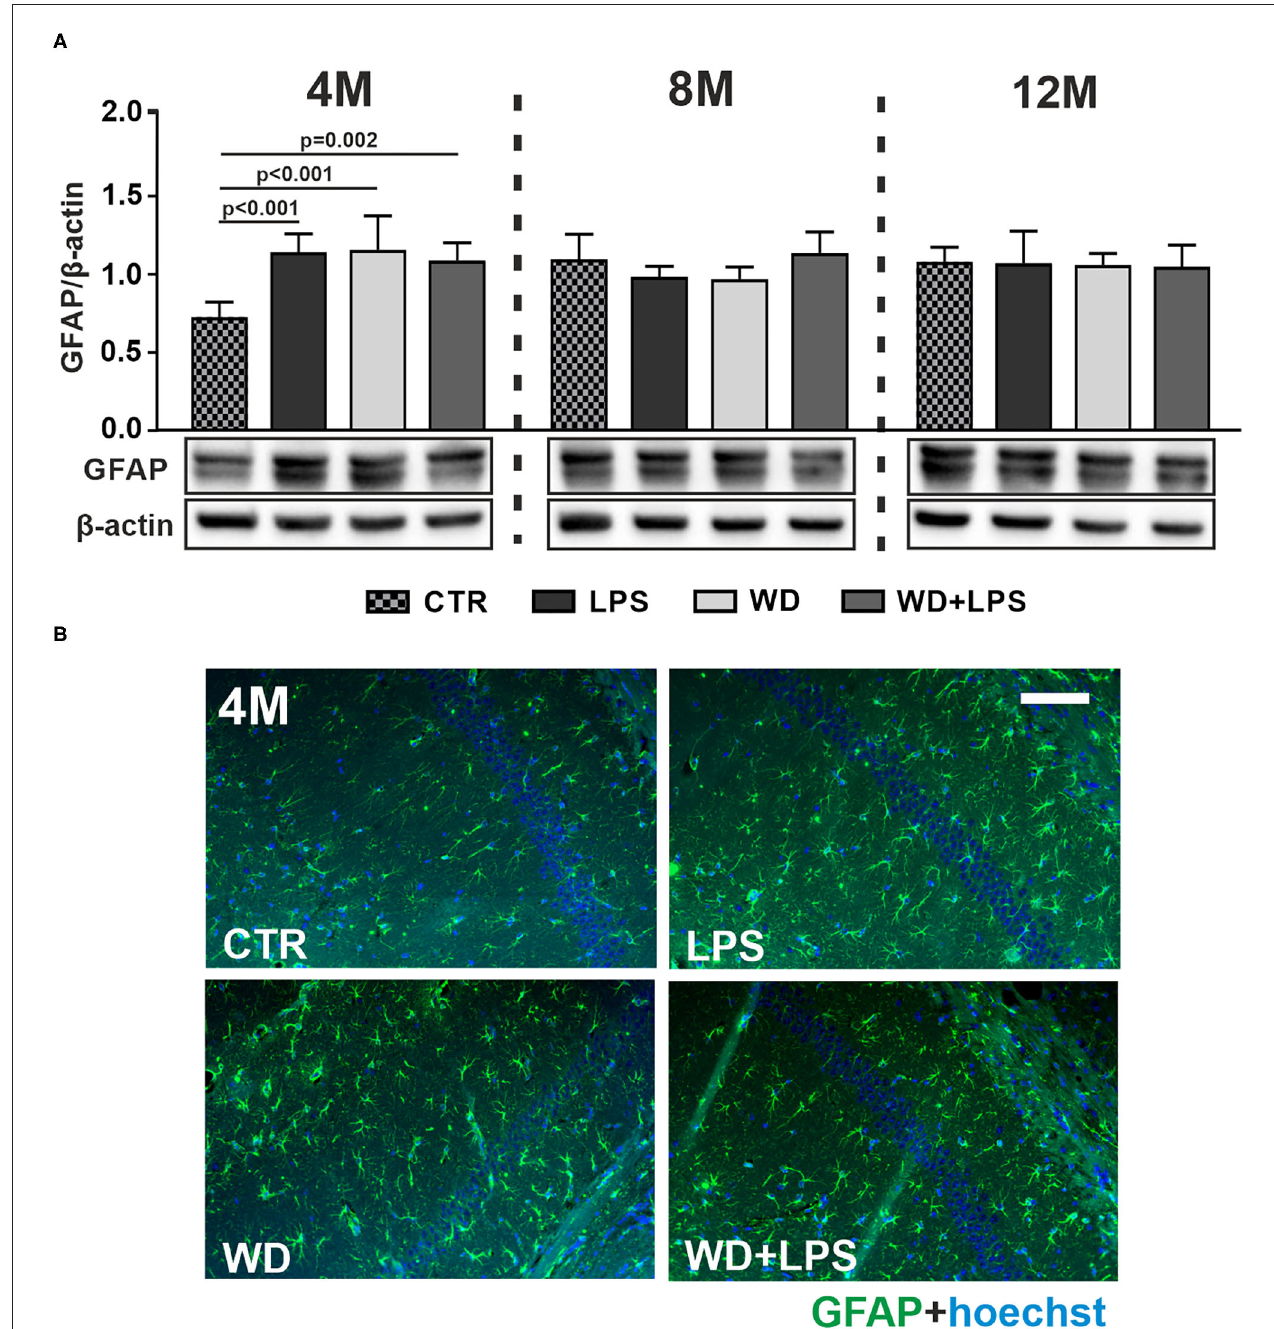
FIGURE 4 | Western diet accelerates astrogliosis in APPswe mouse hippocampus. (A) Graphs show mean GFAP levels detected by immunoblotting in the hippocampal tissue lysates from CTR, LPS, WD, and WD + LPS groups of mice at 4-, 8-, and 12-months of age. Below are representative immunoblots. WD caused increased GFAP levels in the hippocampus of 4-month-old APPswe mice. Data are presented as arithmetic mean of GFAP/actin ± SD ( n = from 4 to 8 animals per experimental group). The statistics were calculated using one-way analysis of variance (ANOVA) followed by Bonferroni’s post-test or non-parametric Kruskal-Wallis test followed by Dunn’s post-test. A p -value of < 0.05 was considered a predetermined threshold for statistical significance. (B) Representing immunofluorescence images show the increases in GFAP staining in the hippocampus in WD and WD + LPS mice compared to CTR mice. All mice were 4-month-old; the scale bar corresponds to 50 µ m; magnification × 20; green fluorescence—GFAP, blue fluorescence—Hoechst (nuclei).